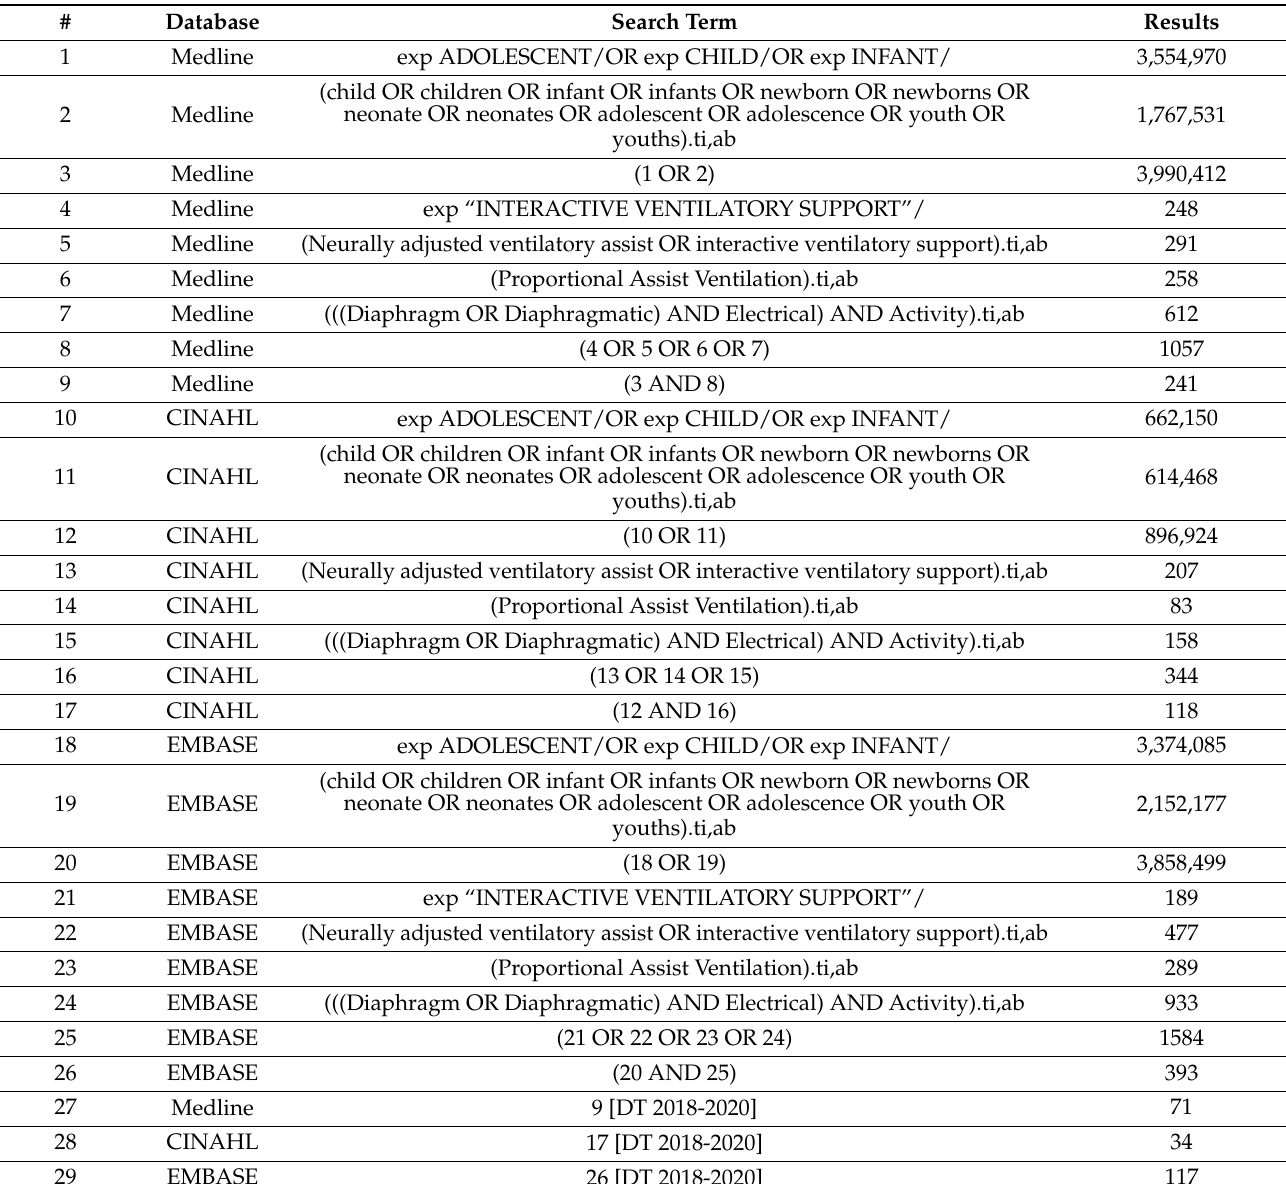
Table A1. Search strategy for the systematic review of NAVA versus conventional weaning modes in